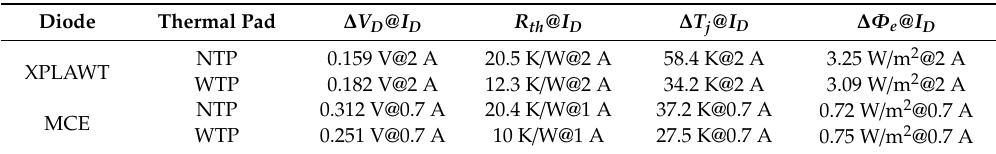
Table 2. The values of selected electric, optical and thermal parameters of the tested power LEDs operating with soldered (WTP) or not soldered (NTP) thermal